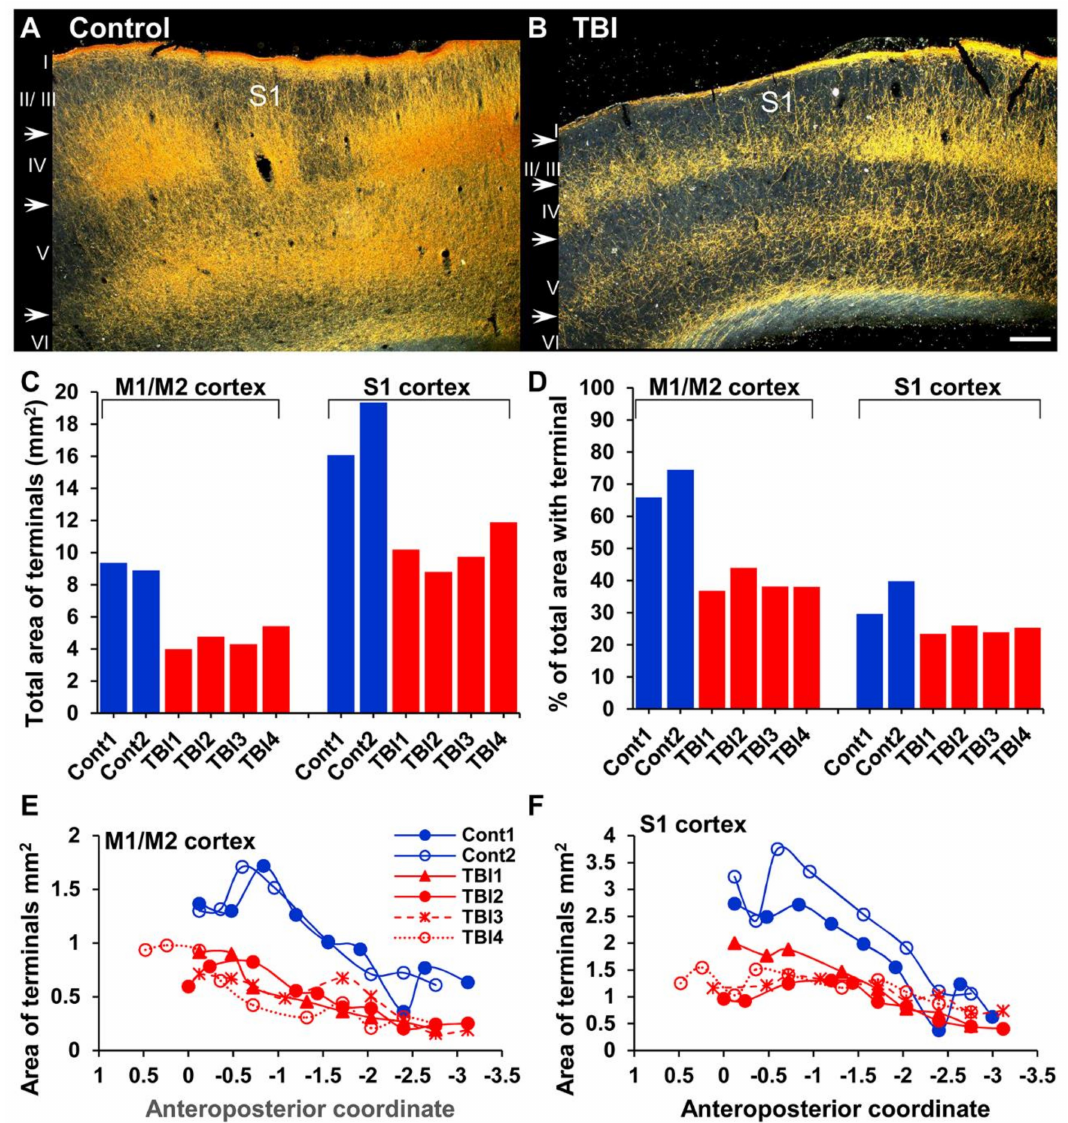
Figure 5. Rostrocaudal distribution of the density of ChR2-eYFP-expressing fibers in the motor and primary somatosensory (S1) cortex of control and traumatic brain injured (TBI) rats. ( A ) Darkfield image of the S1 cortex of a control rat. Note the high density of ChR2-eYFP-expressing fibers. ( B ) Darkfield image of S1 of a TBI rat. Note the reduced density of the ChR2-eYFP-expressing fibers. ( C ) Bar graph showing the total area of the ChR2-eYFP-expressing fibers in the primary (M1) and secondary (M2) motor cortices, and S1. There was a high fiber density in controls as compared to TBI rats in both the M1/M2 and S1 cortices. ( D ) Bar graph showing the percentage of M1/M2 and S1 covered by ChR2-eYFP expressing fibers. ( E ) Rostrocaudal distribution of the density of ChR2-eYFP-expressing fibers in the motor cortex. Note the high density of fibers in rostral sections in both controls and TBI rats. ( F ) Rostrocaudal distribution of ChR2-eYFP-expressing fibers in S1. The density of ChR2-eYFP-expressing fibers is higher in rostral sections compared with the caudal sections. Scale bar equals 200 µ